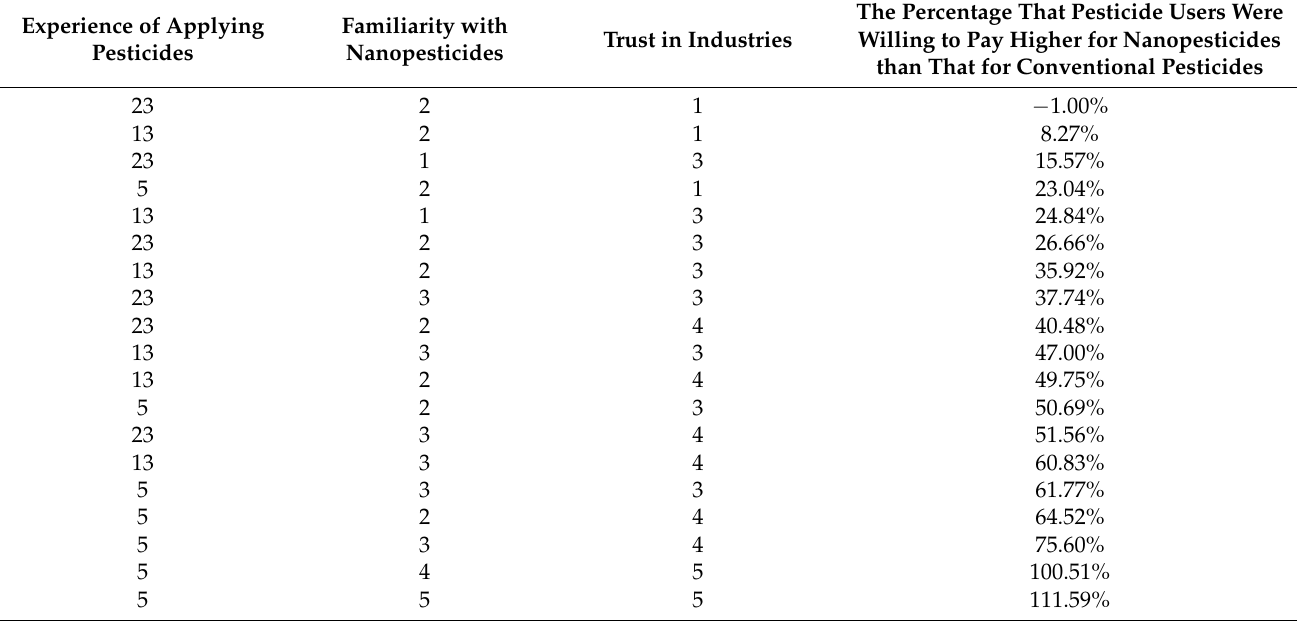
Table A3. Different pesticide user profiles’ willingness-to-pay for